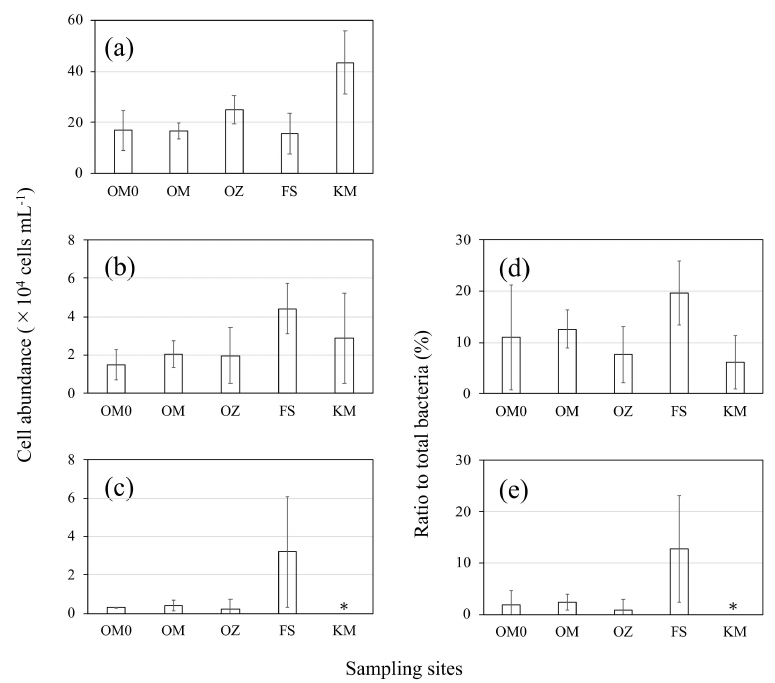
Figure 2. The absolute cell abundances of the total bacteria ( a ), AAnPB ( b ), cyanobacteria ( c ), the relative ratios of AAnPB (%) ( d ) and cyanobacterial (%) ( e ) in Tama River. Asterisks indicate ‘under detection limit’.